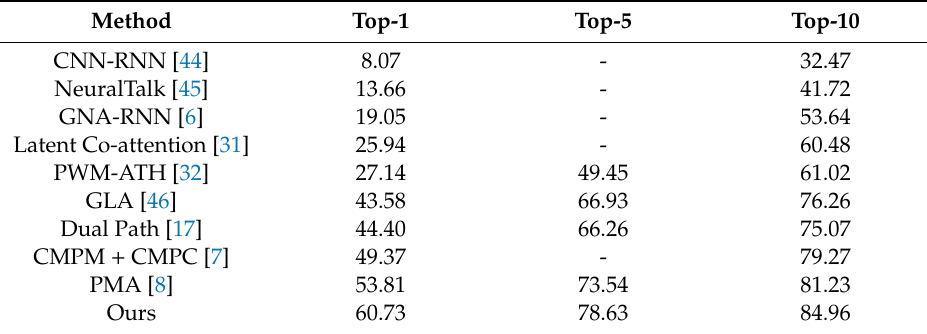
Table 1. Comparison with state-of-the-art (SOTA)